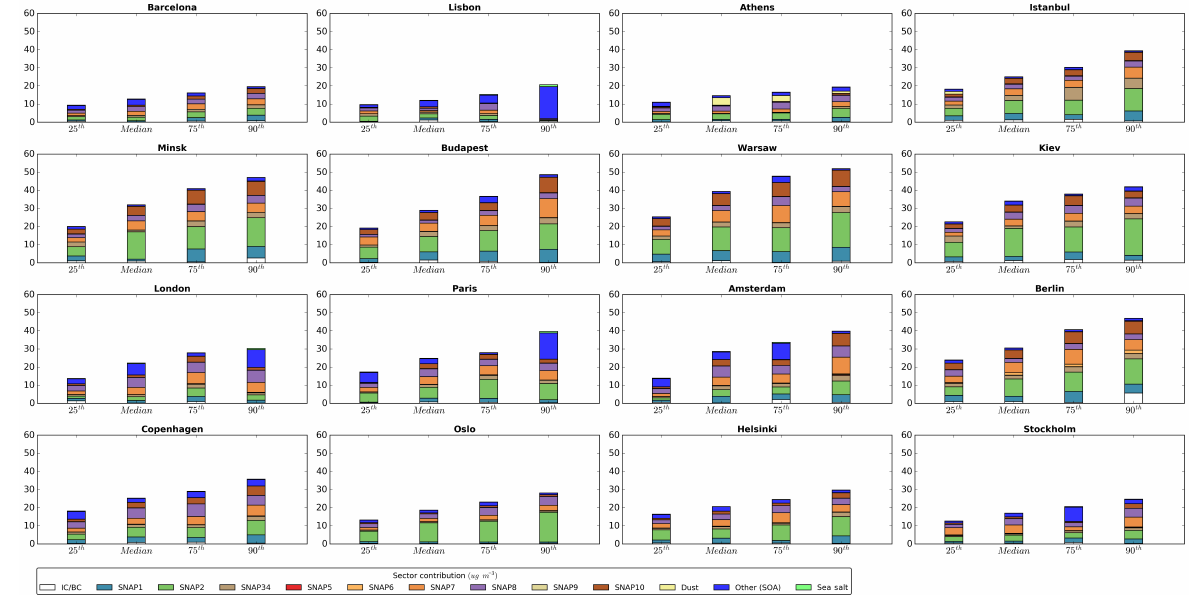
Figure 10. Source attribution results for the distribution of wintertime daily PM 2 . 5 concentrations for the 16